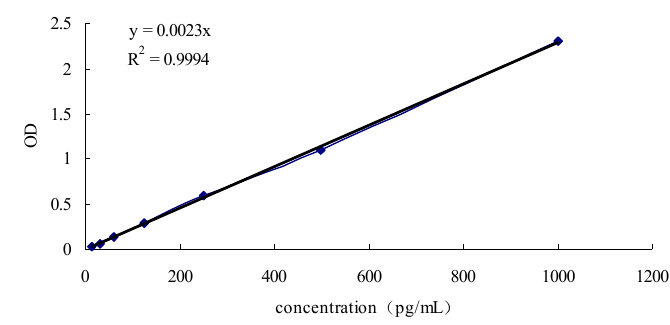
Figure 3. Standard curve of TNF- α